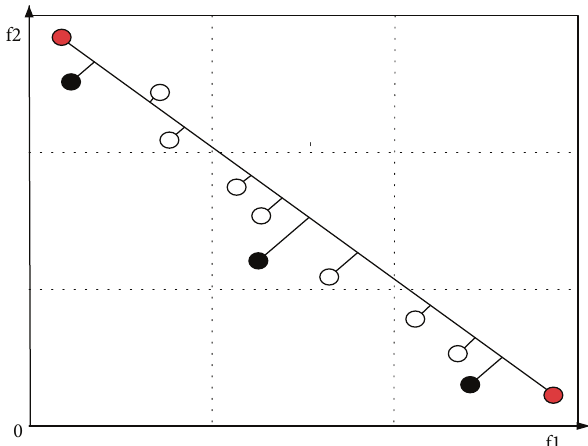
Figure 1: Selection of the global optimal